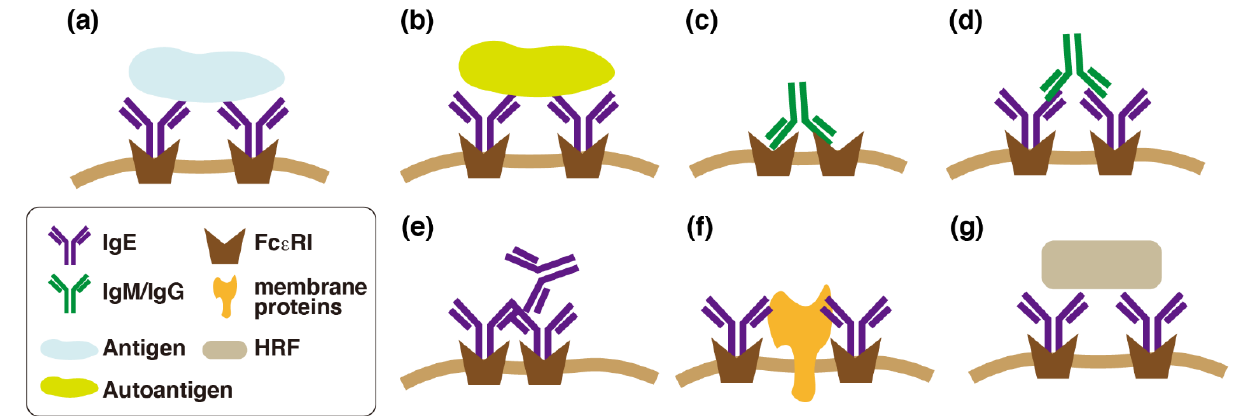
Figure 1. Various modes of Fc ε receptor I (Fc ε RI)-mediated activation of mast cells. ( a ) Mast cells are activated by antigens (allergens) upon immunoglobulin E (IgE)-mediated cross-linking of Fc ε RI. ( b ) Autoantigens recognized by IgE could cross-link Fc ε RI. ( c ) Autoreactive IgMs/IgGs that recognize subunits of Fc ε RI could cross-link Fc ε RI. ( d ) Autoreactive IgMs/IgGs that recognize IgE could cross-link Fc ε RI. ( e ) Aggregated IgEs could cross-link Fc ε RI without the antigens. ( f ) Cis-interaction between IgEs and some glycosylated membrane proteins could cross-link Fc ε RI. ( g ) HRF could cross-link Fc ε RI through interaction with specific types of IgE (IgE +